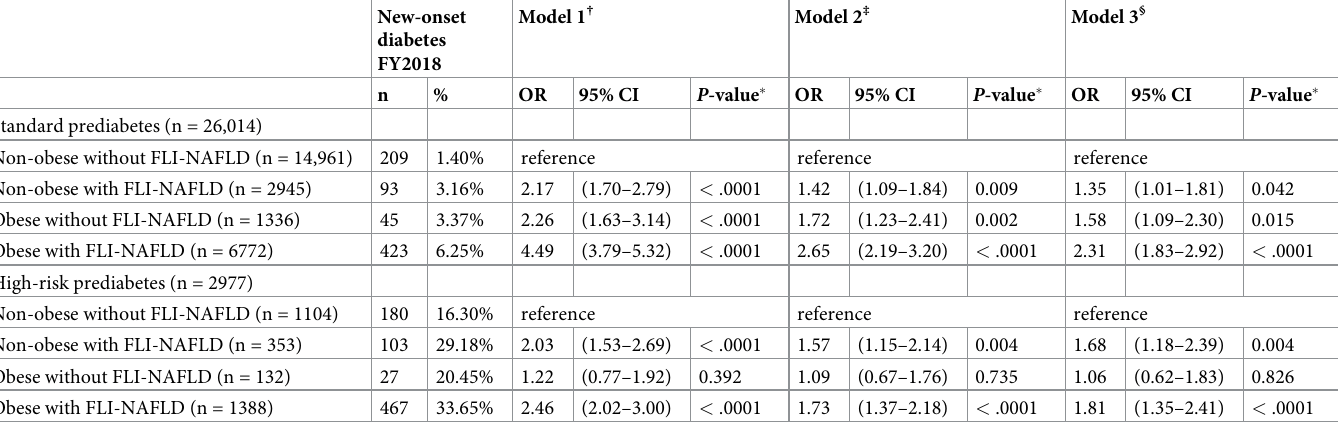
Table 4. Sensitivity analysis of the multivariate adjusted logistic regression model for the incidence of new-onset diabetes by the combination pattern of obesity and FLI-NAFLD, with a cutoff value of FLI of 35 for men and 20 for women.